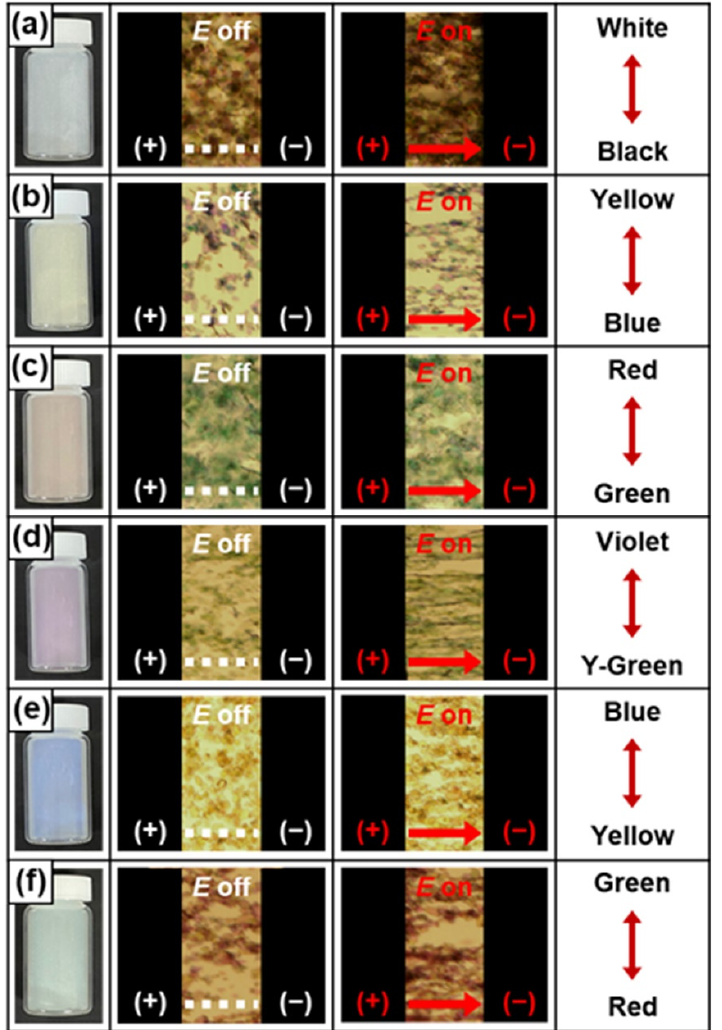
Figure 8. Visual and OM images of fibril-like structures of ( a ) white, ( b ) yellow, ( c ) red, ( d ) violet, ( e ) blue, and ( f ) green mica/TiO 2 -based ER fluids (3.0 wt% in silicone oil) when an E field of 3.0 kV mm − 1 was applied. Complementary colors were observed using an optical microscope.